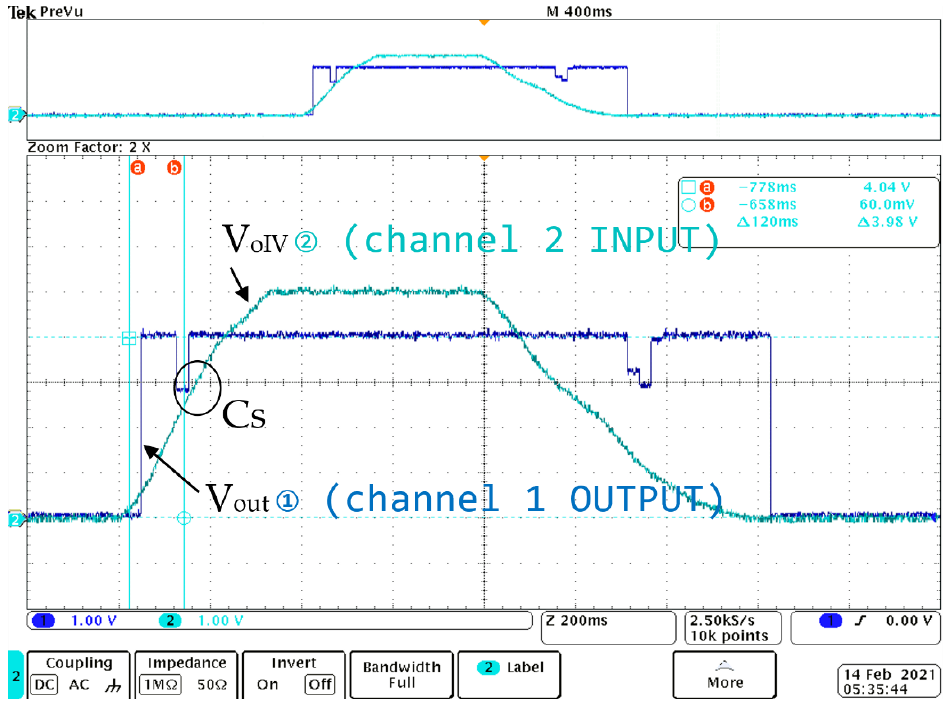
Figure 6. Voltage waveforms for the experimental signal of the input fuzzy AGC, where ( V oiV ) is channel 2 and output is channel 1. (Voltage division Ch1 , Ch2 : 1V/Div, and time base: 200 ms/Div)).